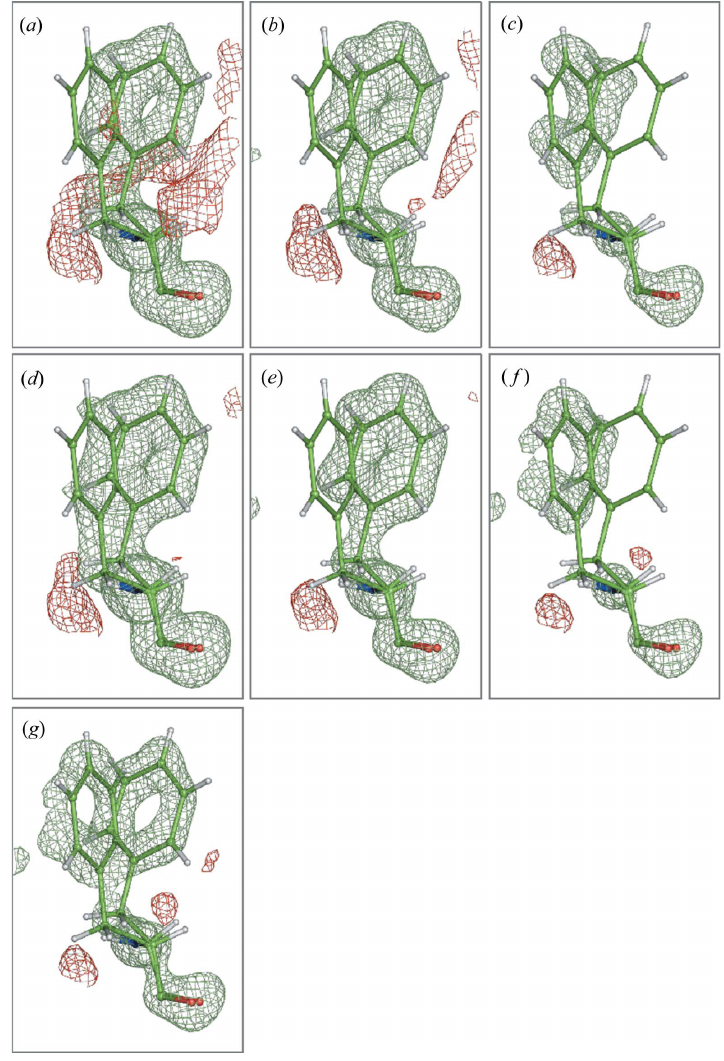
Figure 3 mF o (cid:4) DF c OMIT density maps of Phe92 (chain A) from the structure of a potassium ion channel at atomic resolution contoured at a level of 2.6 (cid:4) . Panels ( a ), ( b ) and ( c ) show conventional OMIT maps, while panels ( d ), ( e ) and ( f ) show polder OMIT maps. In panels ( a ) and ( d ), both conformations of Phe92 have been omitted; in panels ( b ) and ( e ), the A conformation of Phe92 has been omitted; and in panels ( c ) and ( f ), the B conformation of Phe92 has been omitted. In panel ( g ), a composite polder OMIT map is